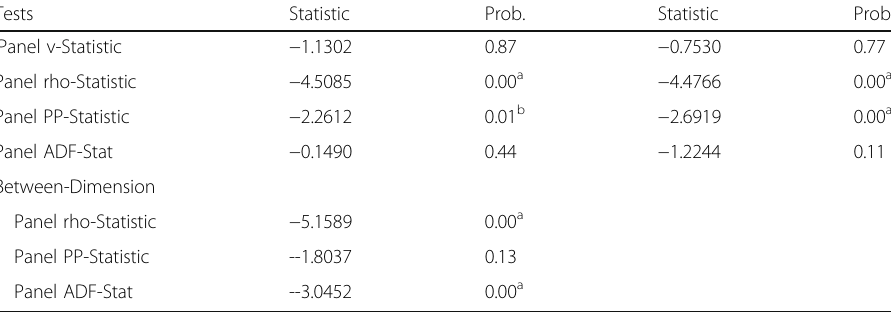
Table 8 Pedroni Cointegration